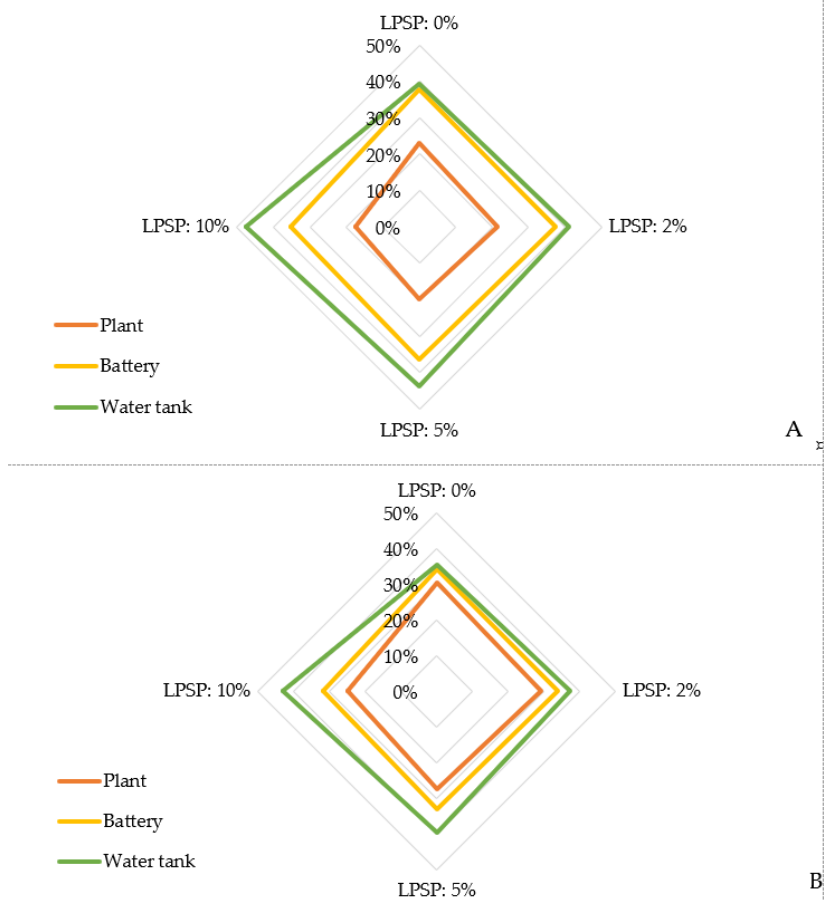
Figure 7. Contribution of various components of the system in the production of freshwater by SWROD/WT/BBS for “ non-renewable, fossil ” impact category based on different LPSP (%) (FU = 1 m 3 ). ( A ) when the battery is full and ( B ) when the battery is empty. The water tank (polyethylene) exhibited the highest effect on the “ non-renewable, fossil ” impact category, followed by battery for all different LPSP (%). Fossil fuels often produce polyethylene. More specifically, ethylene gas is the main ingredient for polyeth- ylene made from crude oil and natural gas [44]. Thathiana Benavides et al. [44] reported that feedstock production, that is, natural gas and crude oil, is the most significant con- tributor to the consumption of fossil fuels in polyethylene production. Although the recy- cling of waste polyethylene is widely regarded as a cost-effective and eco-friendly tech- nology [45], appropriate approaches should be considered that reduce the use of polyeth- ylene. Because the recycling process, in turn, leads to the consumption of fossil fuels, Tha- thiana Benavides et al. [44] suggested bio-polyethylene production instead of fossil-poly- ethylene production. They reported that bio-polyethylene production leads to a reduction of 63% in fossil fuel consumption. In addition to reducing fossil fuel consumption, bio- polyethylene leads to decreased carbon dioxide emissions [44,46,47]. However, in com- parison with fossil-based plastics, bio-based plastics with similar mechanical properties are expensive [48]. Therefore, future research is recommended on the production of bio- polyethylene at competitive prices with polyethylene. Inventory analysis shows that graphite used in battery production has a significant role in the “non -renewa ble, fossil” impact category. According to Notter et al. [49], graph-